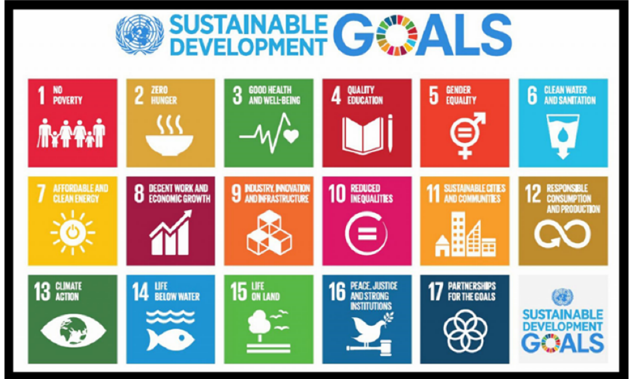
Fig. 2. Sustainable Development Goals (SDGs) 2030